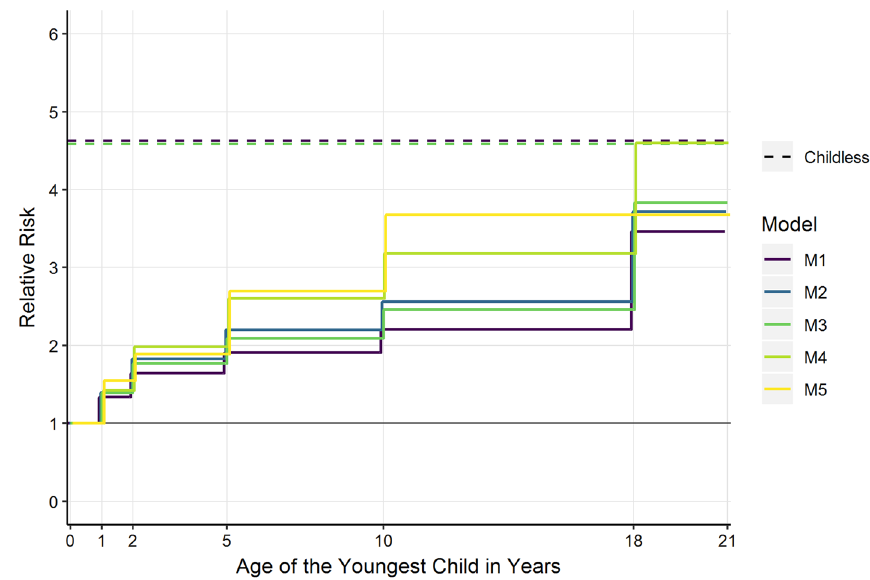
Fig. 2 Models 1–5 (men): relative risk of dying by the age of the youngest